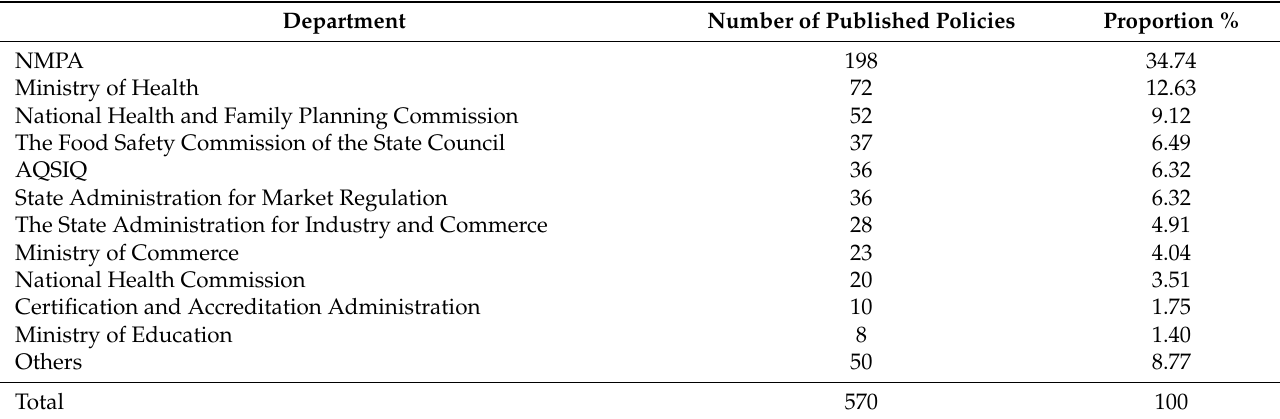
Table 6. Statistics of release departments of central